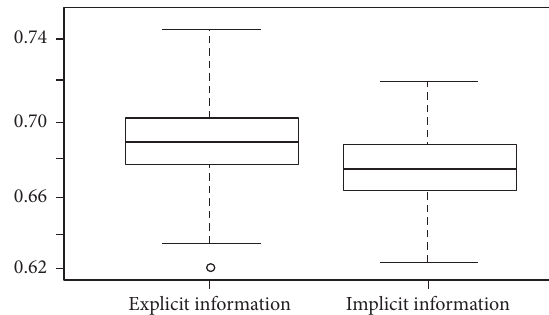
Figure 8: Random forest classification accuracy based on explicit and implicit